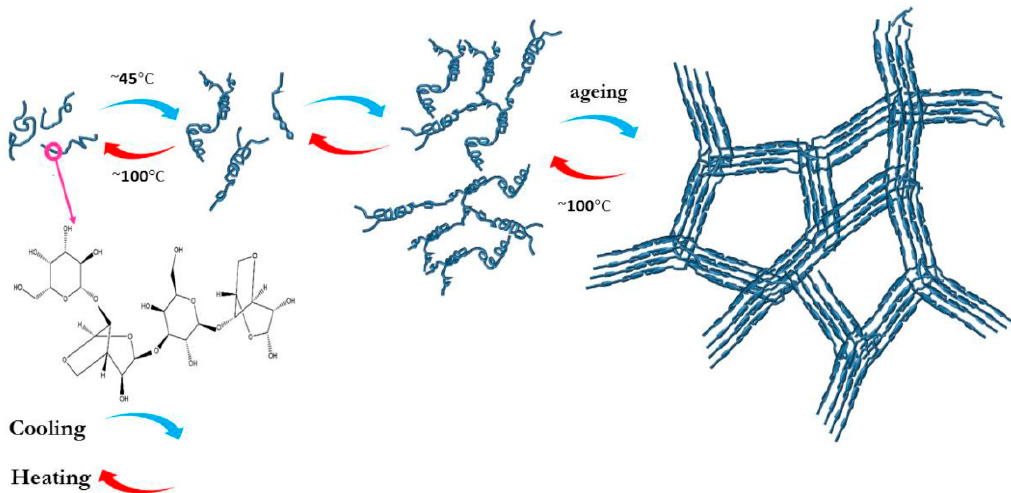
Figure 1. Agarose Gelation Mechanism: agarose chains lean to form helical structure and gel because of the hydrogen bonding and electrostatic interaction.